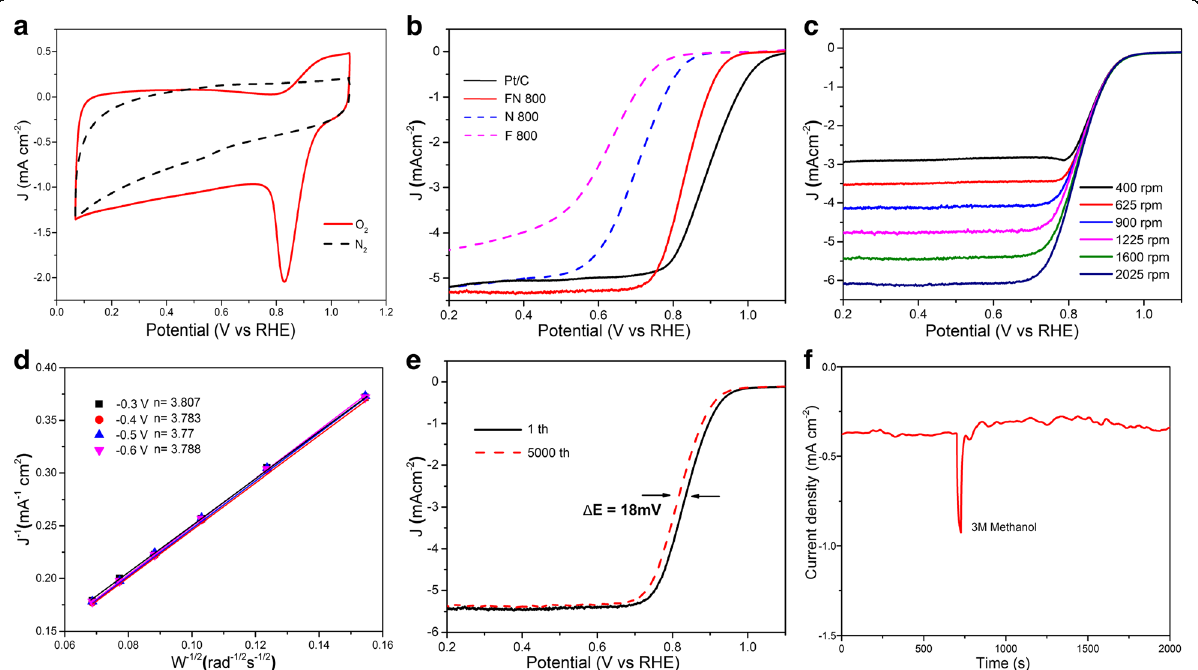
Fig. 4 a CV curves of FN-800. b LSV curves of FN-800, F-800, N-800, and Pt/C in 0.1 M KOH solution. c RDE curves of FN-800 at various rotation rates. d The corresponding K – L plots ( J − 1 vs. ω − 1/2 ) at different potentials. e LSV curves of FN-800 in 0.1 M KOH solution: initial and after 5000 cycles. f Methanol tolerance test of